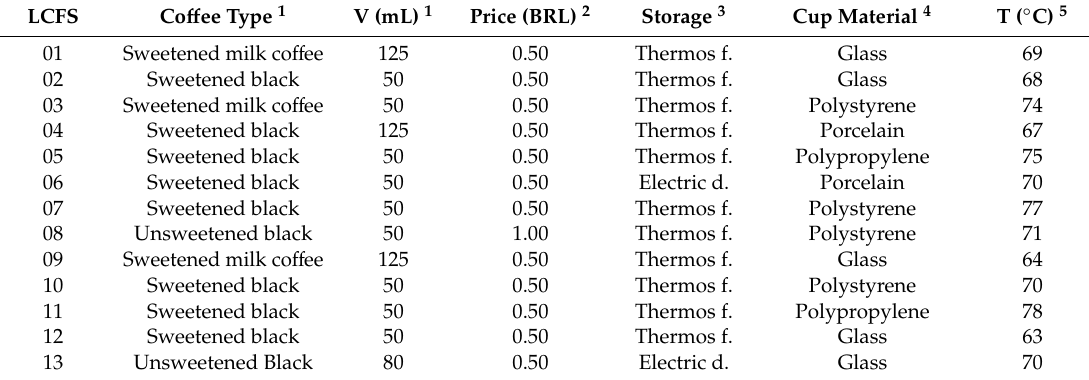
Table A1. Serving temperatures and other information of best-selling co ff ee beverages in 50